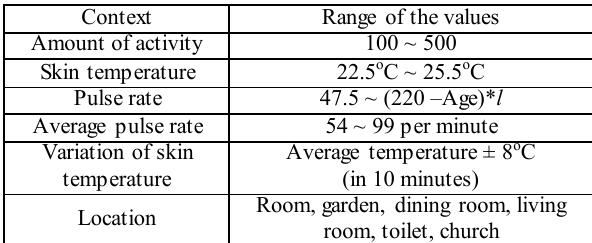
Table 2. The contexts of the medicare service and acceptable range of the values.